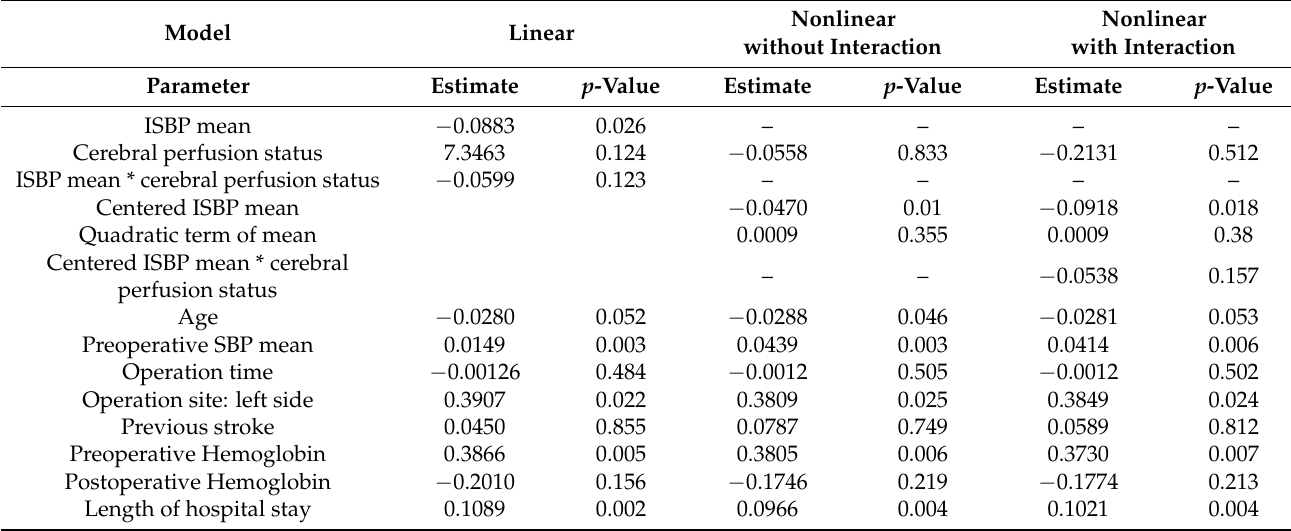
Table 3. Estimates from the multivariable logistic regression models on ISBP mean.